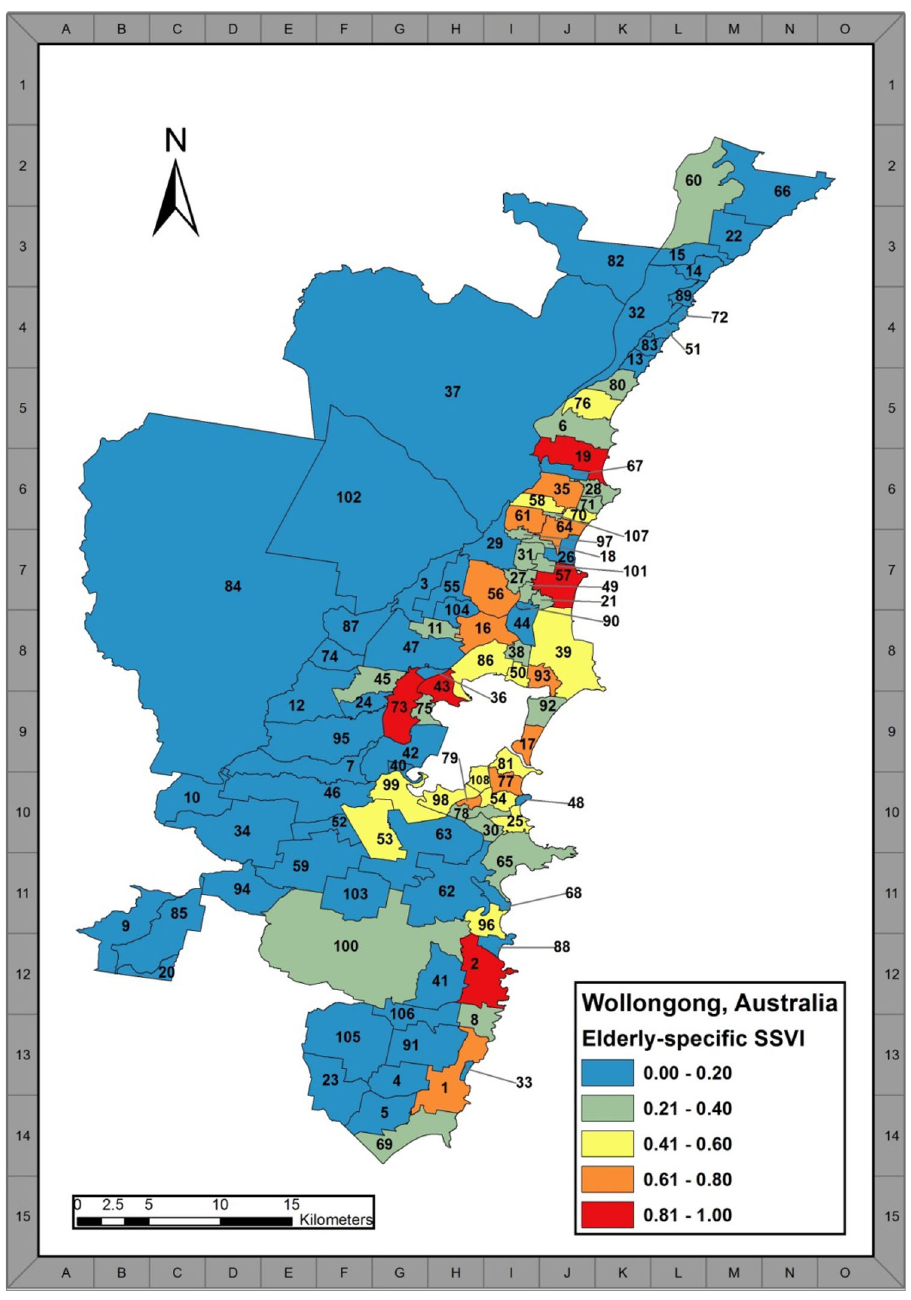
Fig. 6 Spatial distribution of elderly-specific strength-based social vulnerability index (SSVI) in the Wollongong area of New South Wales